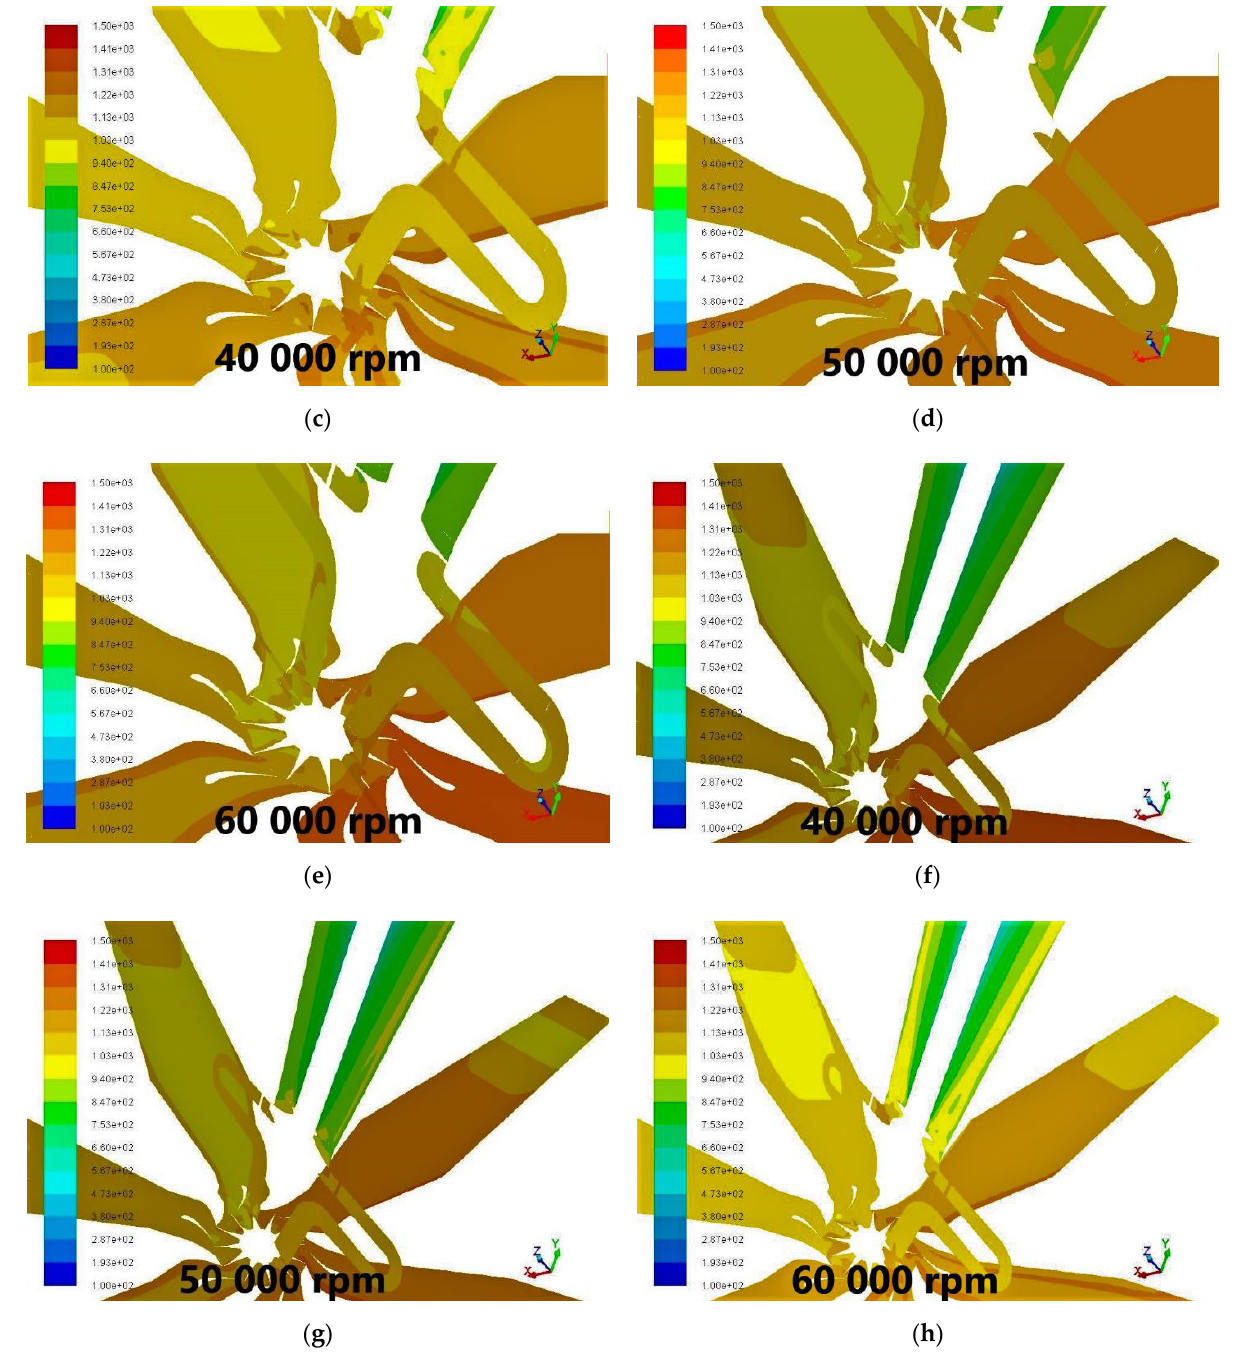
Figure 16. The temperature plots for three different turbine speeds monitored at: ( a ) the Section 2-2; ( b ) the Section 4-4; and the contours of the total temperature behind the: ( c – e ) first-stage rotor at the state A; ( f – h ) second-stage rotor at the state B.